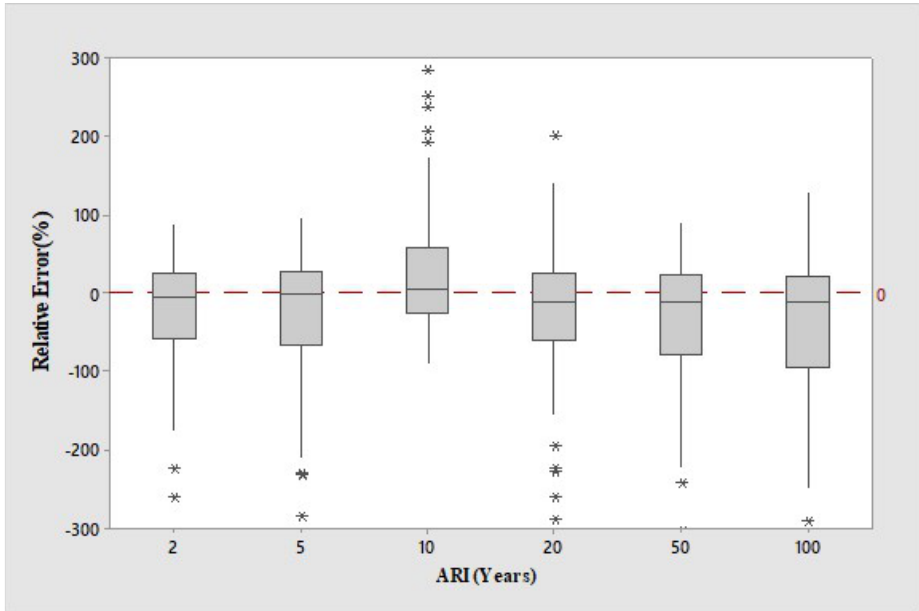
Figure 4. Boxplots of RE values for the GAM model of combined group (* represents outliers).